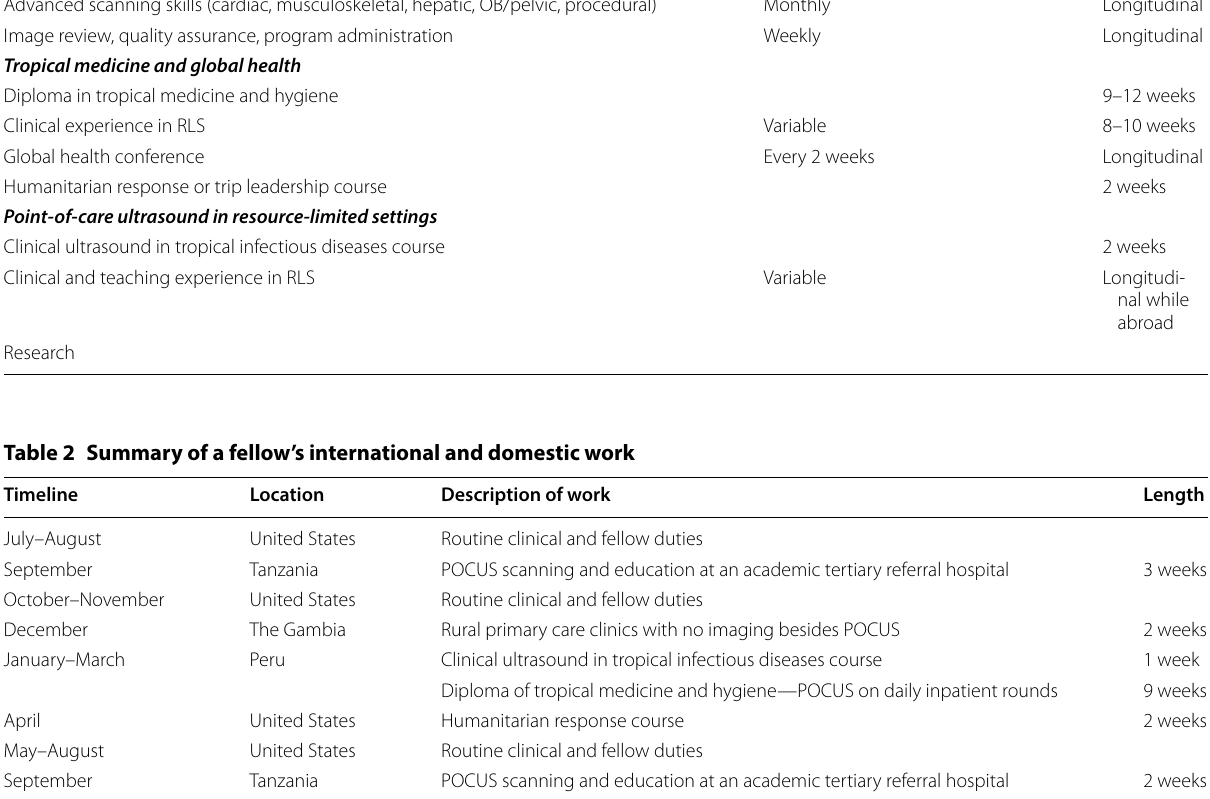
Table 1 Overview of PURLS fellowship curriculum components Content area Emergency ultrasound Bedside scanning and teaching shifts with students and residents